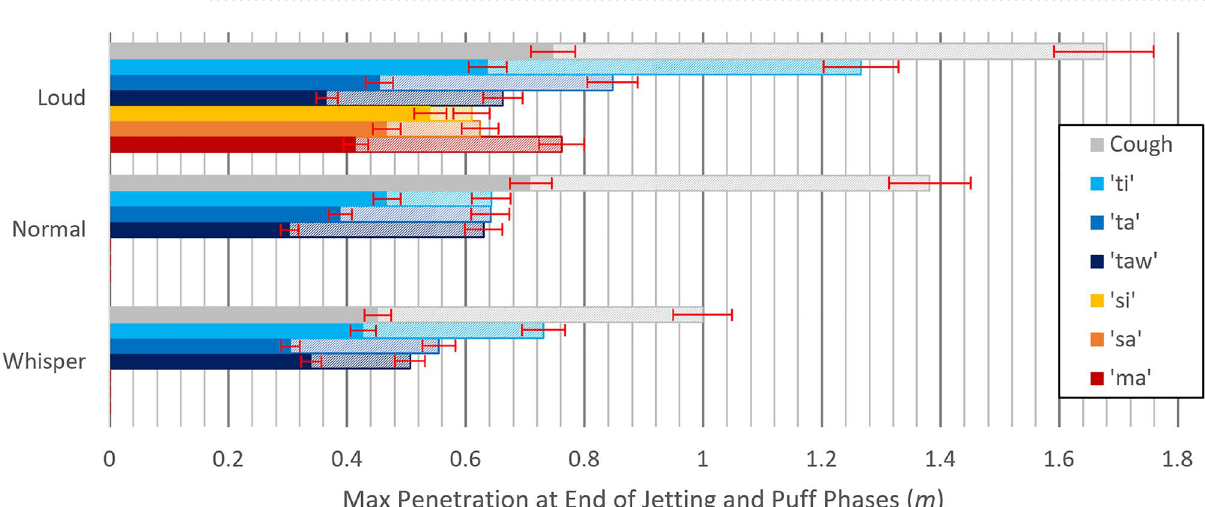
Figure 6. Maximum aerosol penetrations at the end of the jetting phase (filled bars) and subsequent puff phase (empty bars). Uncertainty is estimated based on the velocity measurement uncertainty of the PIV cross-